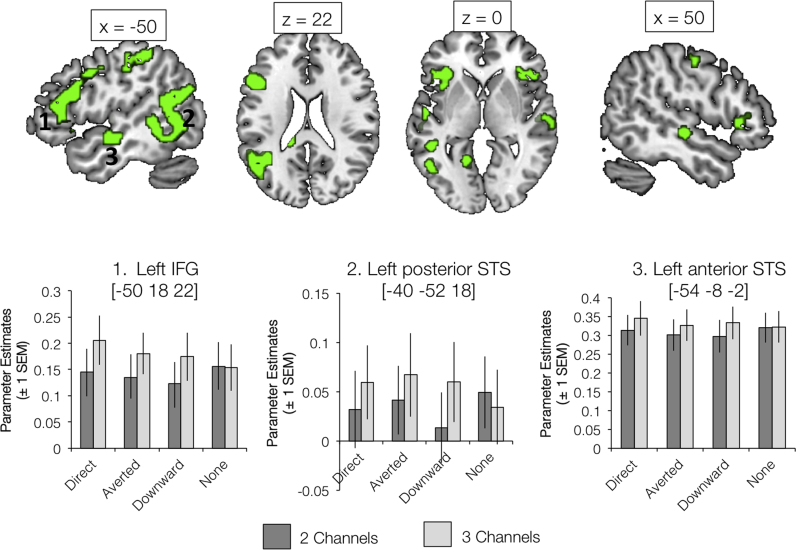
Significant clusters showing a main effect of Auditory Clarity. Activations are shown at a voxel height threshold of p<0.005 and a corrected cluster extent threshold of p<0.001 (Slotnick et al., 2003). Plots show parameter estimates (±1 S.E.M.) taken from 4 mm-radius spherical regions-of-interest built around selected peak voxels (using the MarsBaR toolbox in SPM; Brett et al., 2002). Coordinates are given in Montreal Neurological Institute stereotactic space.